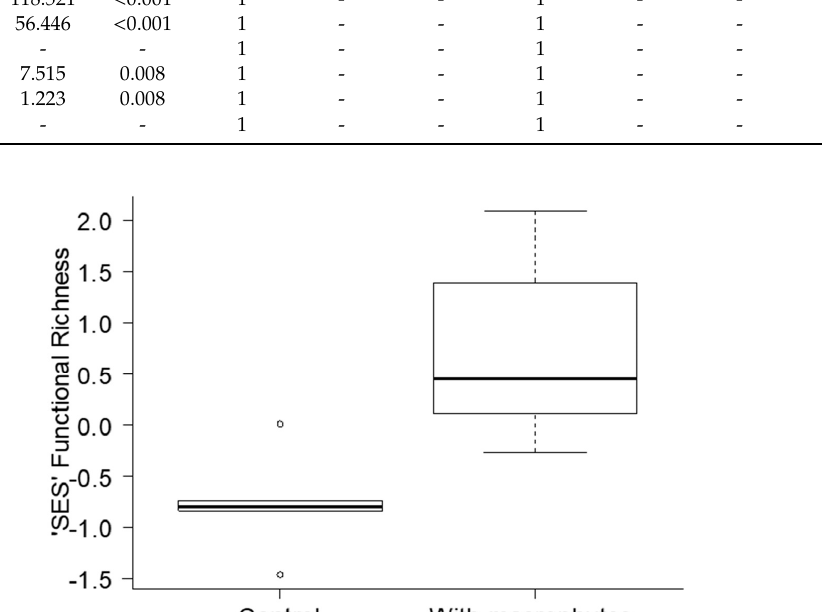
Figure 5. Box plots showing the means and standard errors of rankings of standardized effect sizes (SES) for functional diversity comparing the two treatments ( p -value < 0.001). (SES) for functional diversity comparing the two treatments ( p -value <